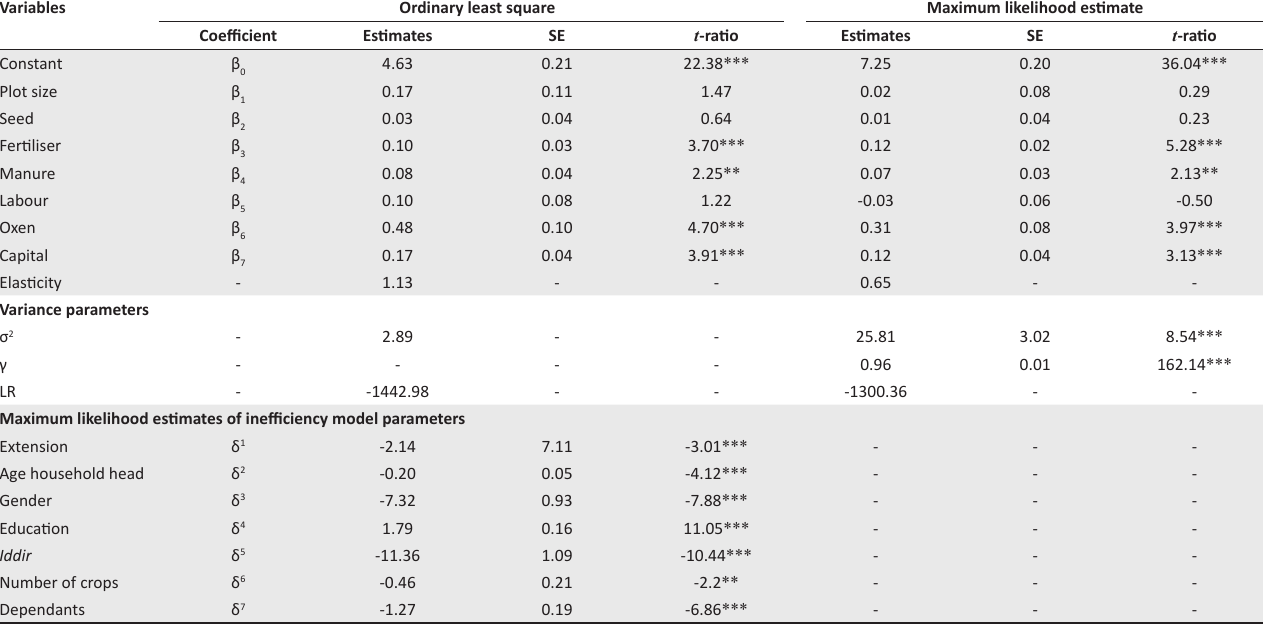
TABLE 2: Ordinary least square and maximum likelihood estimates of the stochastic production frontier analysis ( n =